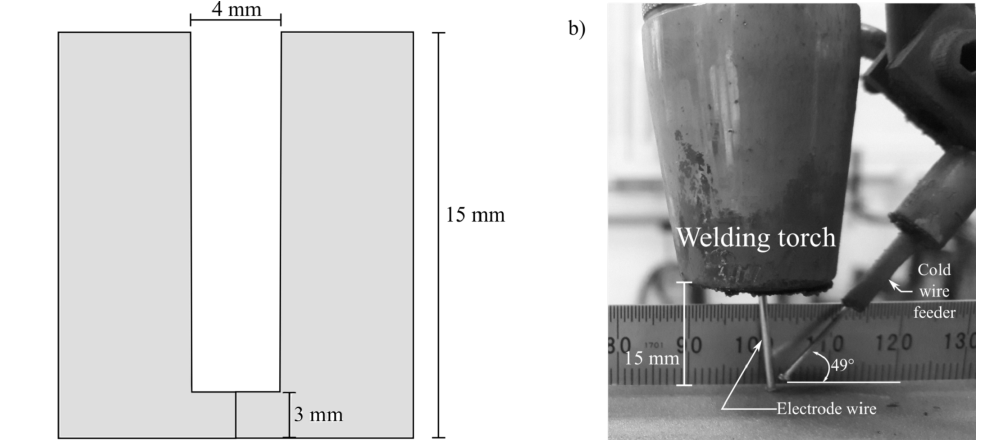
Figure 1. Schematics of the groove geometries used in this work: ( a ) schematic of the narrow groove, showing the cross-section; and ( b ) detail of CW positioning and feeding angle. Table 1. Nominal chemical composition of the welding wires and the base